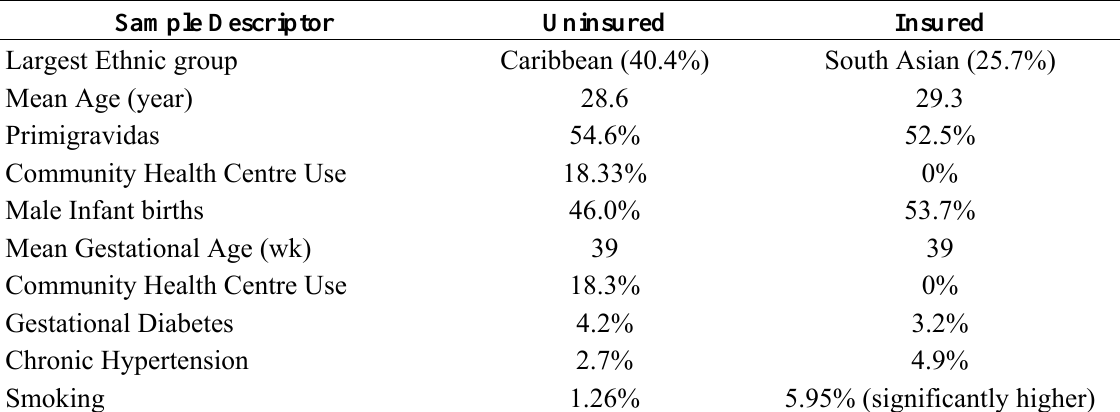
Table 1. Socio-demographic and clinical description of the sample groups ( n =